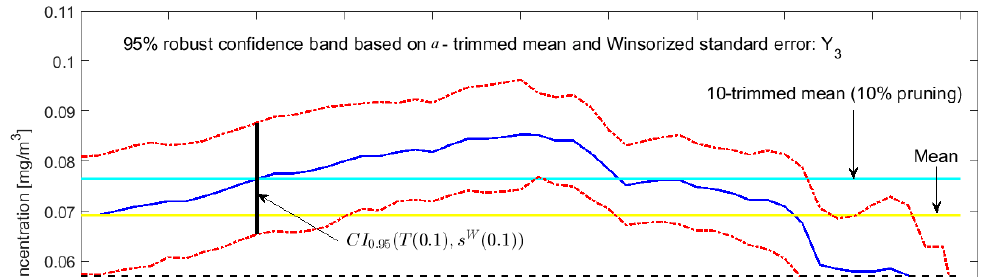
Figure 13. 95% robust confidence band based on the biweight estimators: X 1 .